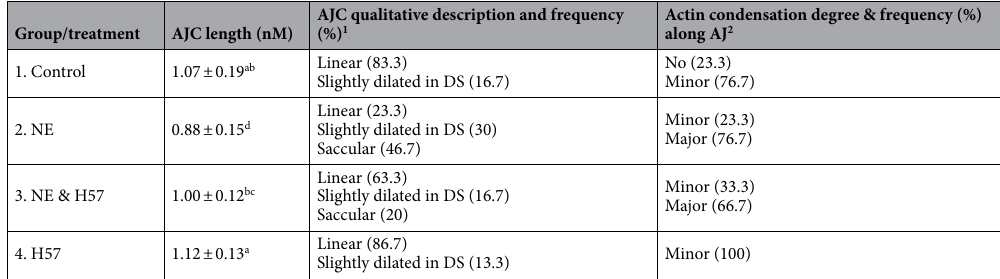
Table 1. Apical junctional complex (AJC) length and morphology sourced from TEM micrographs of 21 d old chicks. Groups are identified as: control (chicks were not treated with any pathogen and fed a basal diet not supplemented with the probiotic H57); NE (necrotic enteritis) chicks received a co-infection with Eimeria vaccine and Clostridium perfringens ( Cp ) and were fed a basal diet not supplemented with the probiotic H57; NE & H57 chicks were exposed to Eimeria vaccine and Cp , and fed a basal diet supplemented with the probiotic H57; H57 chicks were not treated with any pathogen but fed the control diet supplemented with the probiotic. 1 The number in brackets represents the frequency (%) of the qualitative description (linear vs. slightly dilated vs. saccular) found in the images observed. 2 The number in brackets represents the frequency (%) of the actin condensation degree (no vs. minor vs. major) found from the images observed.